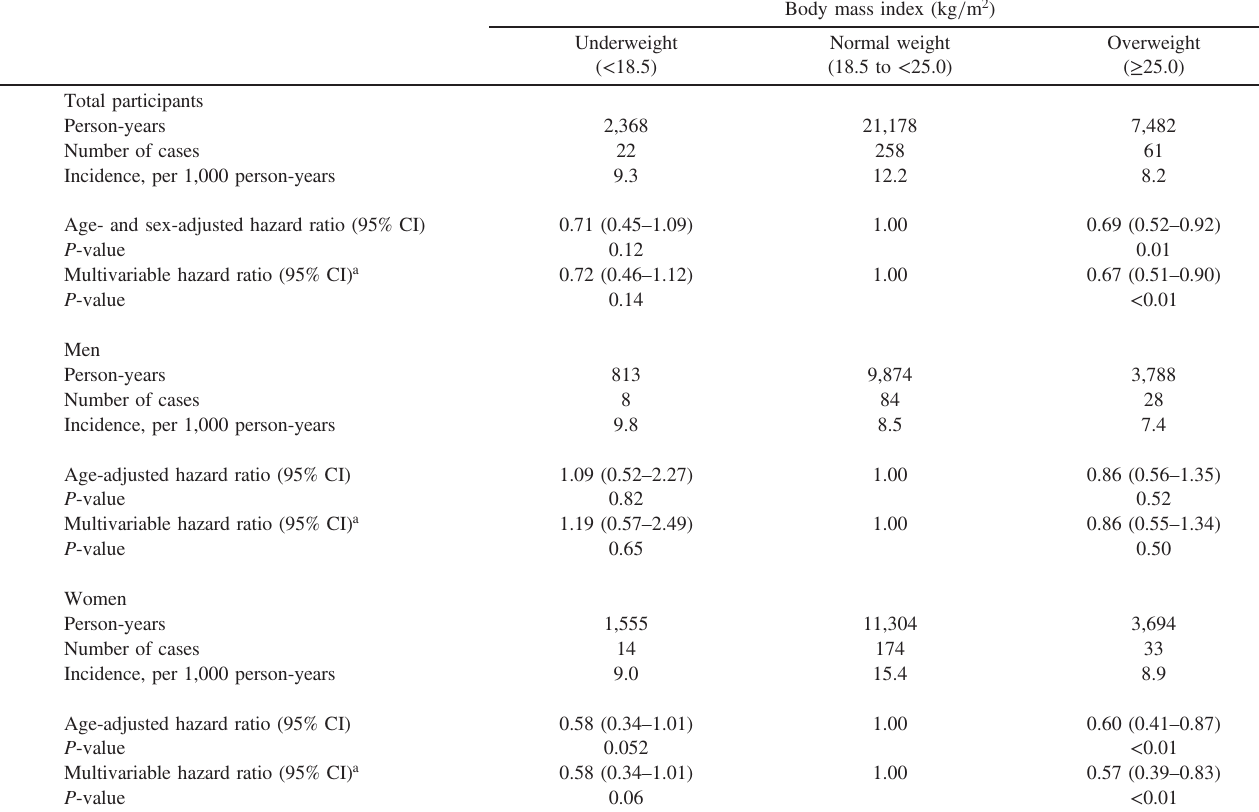
Table 3. Hazard ratios of incident herpes zoster by body mass index category in all participants, men and